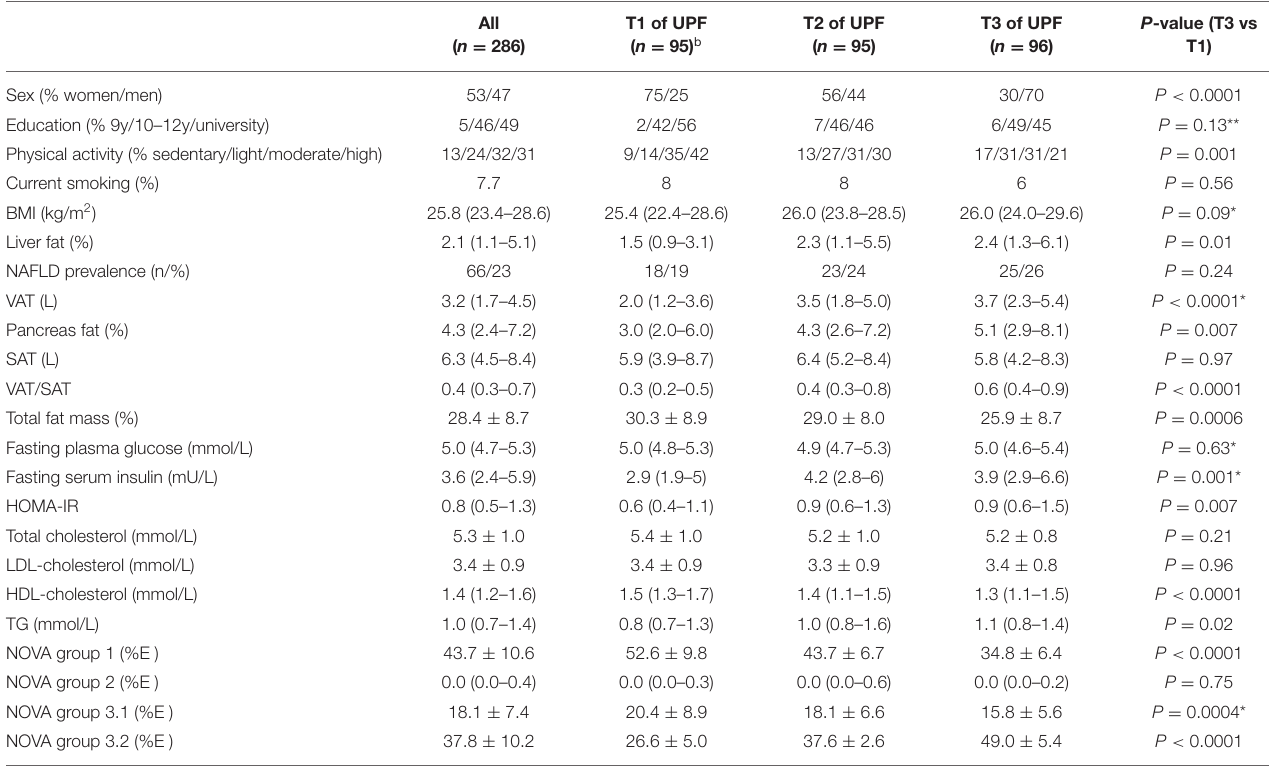
TABLE 1 | Characteristics of the study population ( n = 286) a .